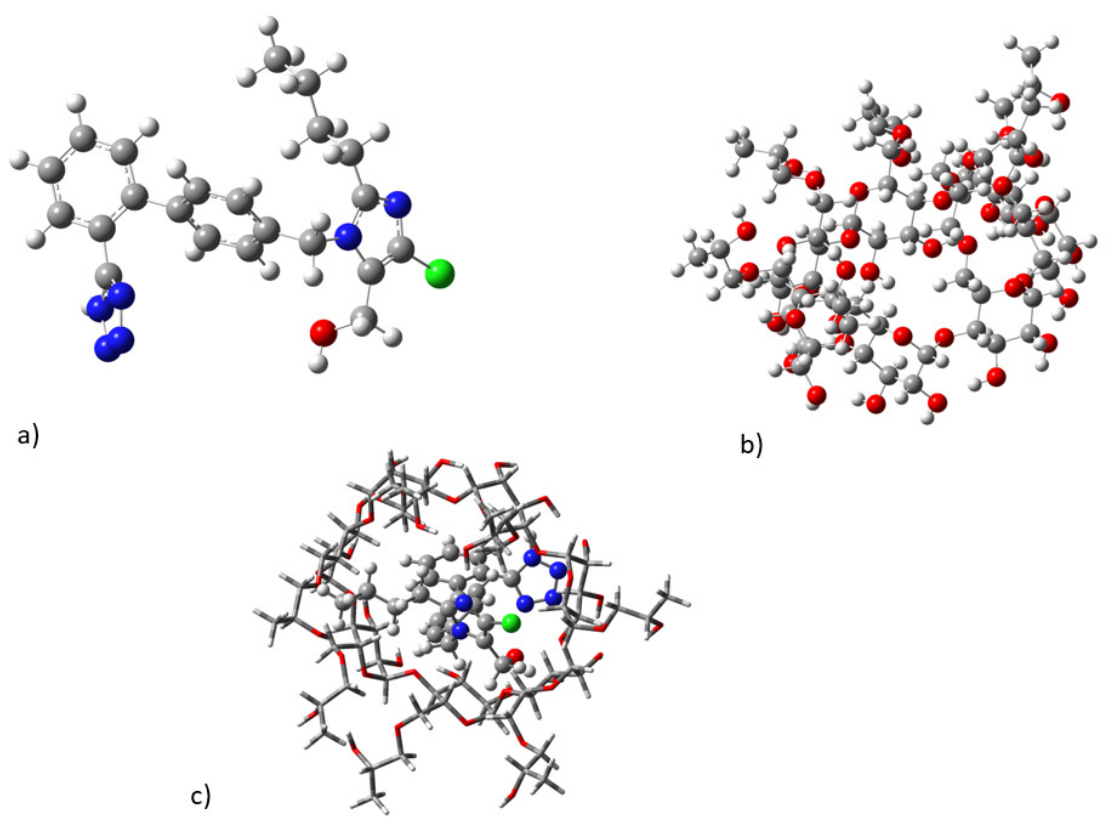
Figure 7. Calculated minimum energy structures: ( a ) losartan; ( b ) cyclodextrin; ( c ) losartan–cyclodextrin complex in water solvent at B3LYP/6 ‐ 311G (d, p).